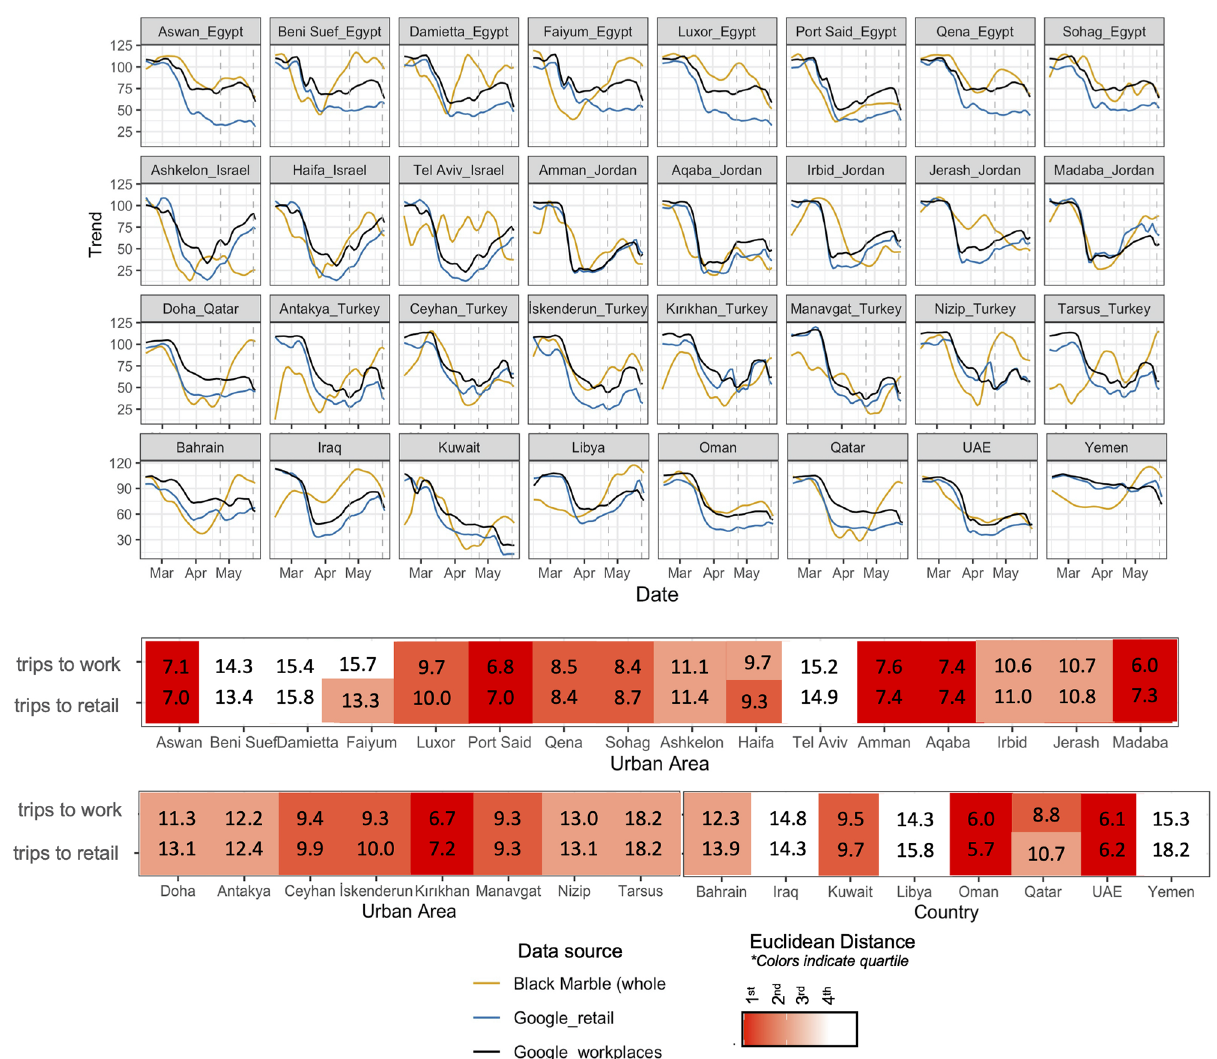
Figure 2. (Top) A visual comparison of Google mobility data time-series against Black Marble data (converted to the same scale) for urban areas in the Middle East. Ramadan period is framed by dashed grey lines). (Bottom) A euclidean distance measure between the Black Marble time series and Google mobility time series shows which cities and countries had high synchronicity between the datasets. Figure created using ggplot2 version 3.3.5 33